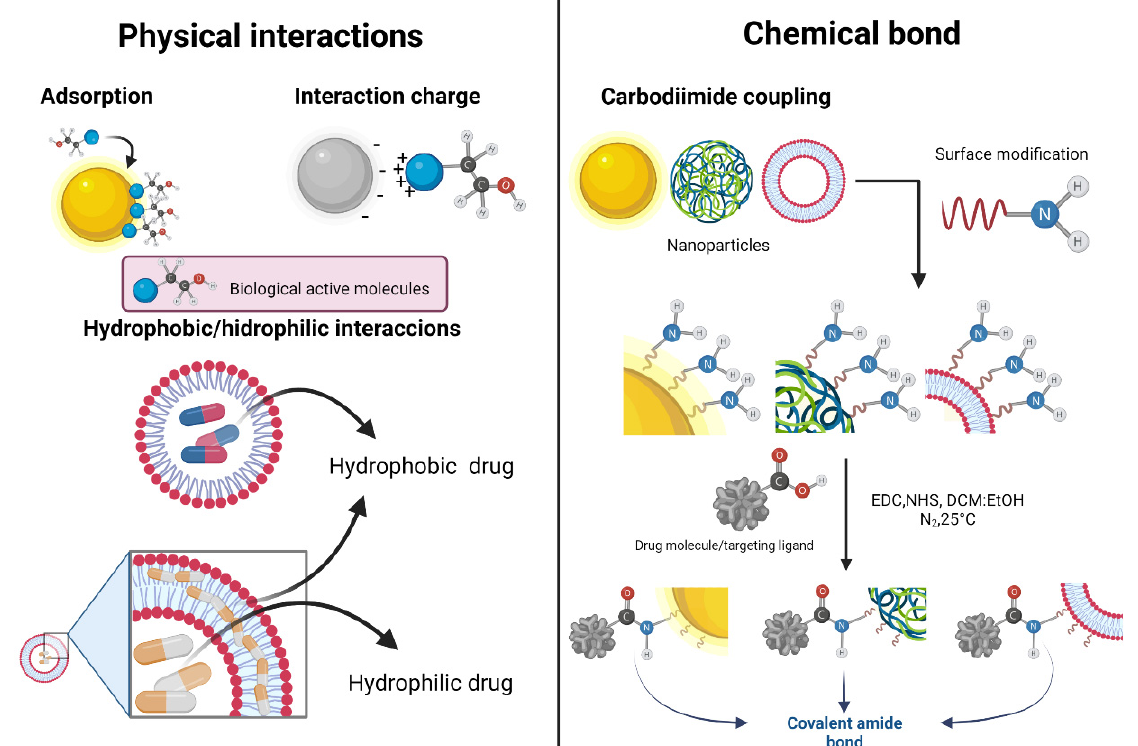
Figure 1. Physical and chemical interactions of nanoparticles for functionalization, drug loading, or radiolabeling. Physical methods include adsorption, interaction charge, and hydrophobic or hydrophilic interactions. Chemical bonds can be formed by carbodiimide coupling.